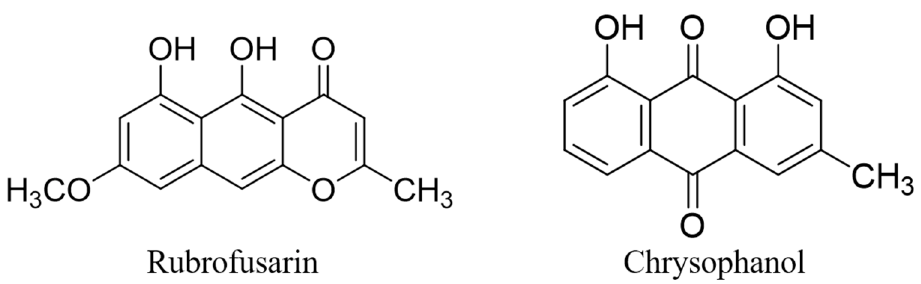
Figure 2. Structures of isolated compounds rubrofusarin and chrysophanol. HPLC, high-perfor- mance liquid